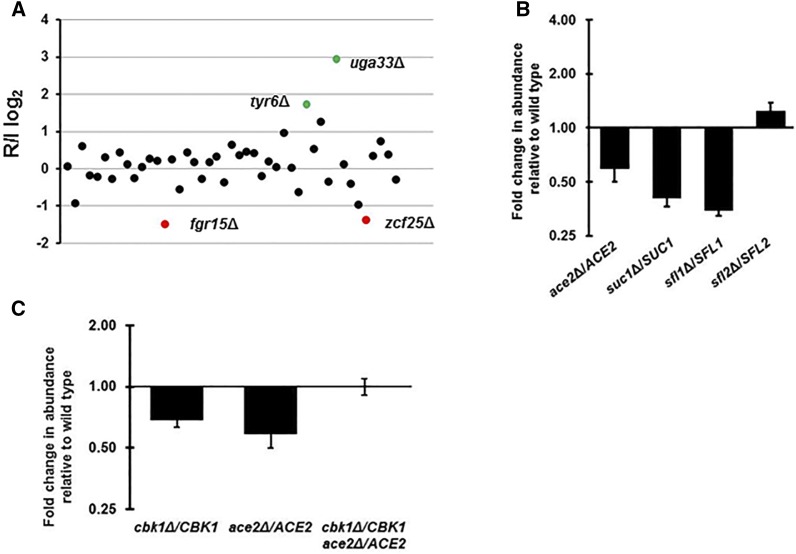
TF heterozygous strains have altered competitive fitness at early stages of dissemination in a murine model of candidiasis. A. CDR1 mice were infected with pools of orthogonally barcoded heterozygous deletion mutants and harvested at 24 or 48 hr post infection (N = 5 for each time point). The competitive fitness was calculated as described in Materials and Methods. Competitive fitness data from representative pool of 48 heterozygous strains is shown. Mutants with statistically significant (P < 0.05, Student’s t-test with Benjamani-Hochberg correction for multiple comparisions) decreased (red points) or increased (green points) competitive fitness relative to the median pool R/I. B and C. Competitive fitness of the indicated strain relative to a wild type reference strain. Bars indicate means of 3-5 independent mice with error bars indicate standard error of the means.